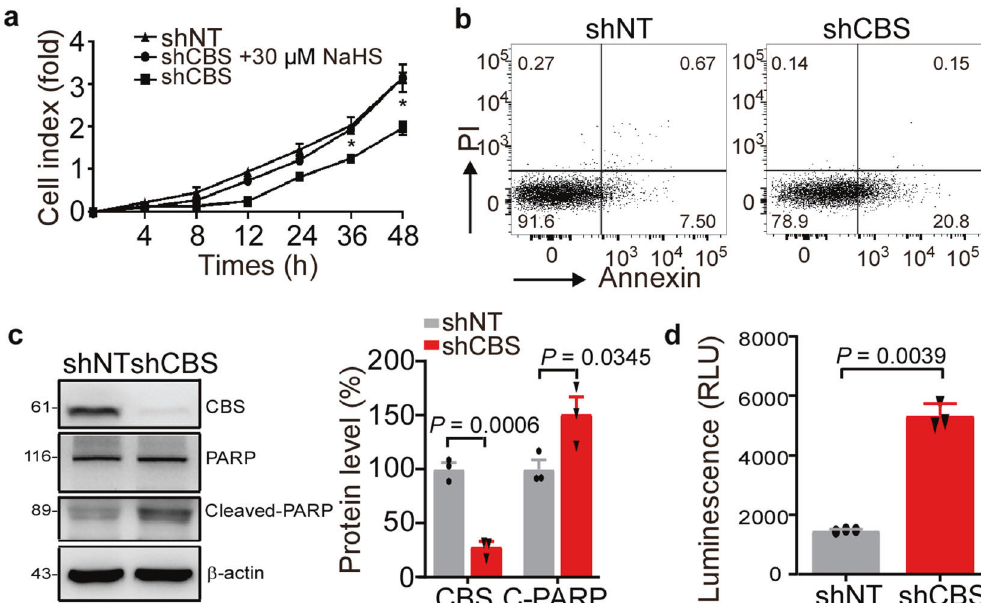
Fig. 3 Knockdown of CBS expression by shRNA increased K562 cell apoptosis. a K562 cells were transfected with CBS-shRNA lentiviral vector (shCBS) or a non-targeting sequence vector as the control (shNT). The transfected cells were then treated with or without NaHS (30 μ M). The cell viability was detected by performing the MTT assay ( n = 3). b shNT and shCBS transfected K562 cells were stained with Annexin V-APC/PI and subjected to fl ow cytometry analysis ( n = 3). c Western blot analysis was performed to detect the expression of CBS and PARP in the shNT and shCBS transfected K562 cells ( n = 3). d Caspase 3/7 activity was measured by chemiluminescence ( n = 3). The results are expressed as mean ± SEM. Two-tailed Student ’ s t test was used to analyze the difference between 2 groups, and multiple comparisons were analyzed by ANOVA followed by Tukey ’ s multiple comparisons test. * P <